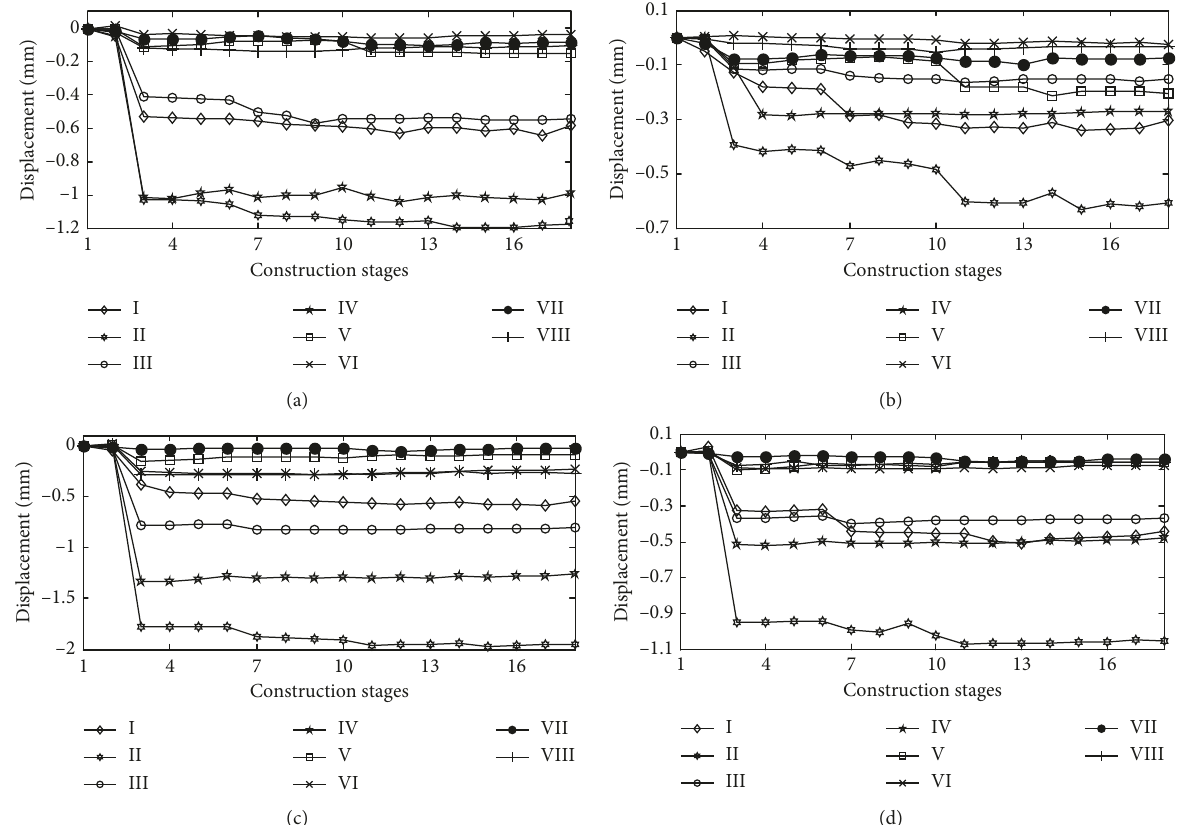
Figure 12: Comparison of horizontal displacement of existing buildings: (a) the top of the left building; (b) the bottom of the left building; (c) the top of the right building; (d) the bottom of the right